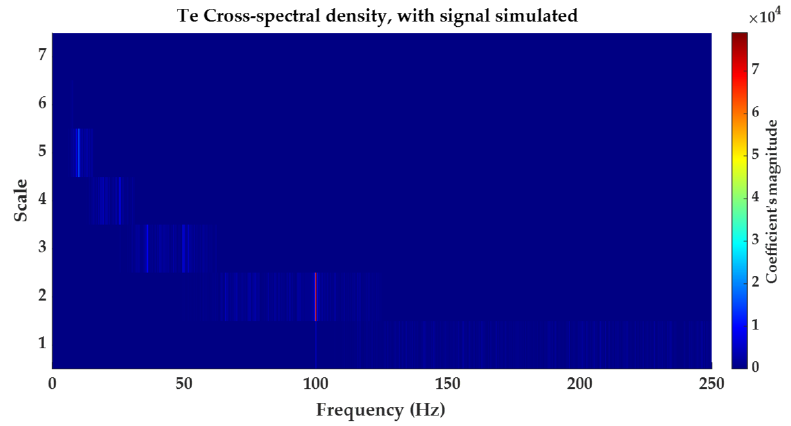
Figure 3. Coherence, with two synthetic signals: 𝑆 (cid:2869) = 𝑠𝑖𝑛(2𝜋10𝑡) + 𝑠𝑖𝑛(2𝜋100𝑡) and 𝑆 (cid:2869) = 𝑠𝑖𝑛(2𝜋50𝑡) + 𝑠𝑖𝑛(2𝜋100𝑡) .